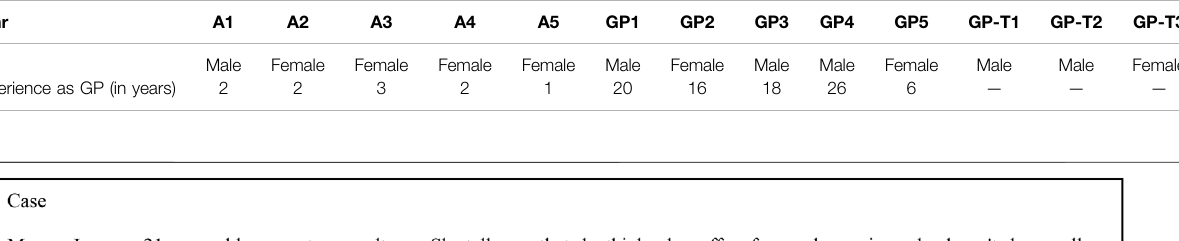
TABLE 1 | Participants characteristics.